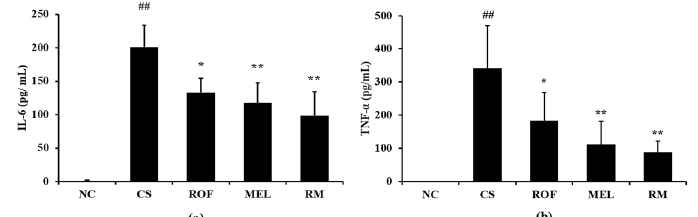
Figure 3. Melatonin decreased inflammatory cytokines in BALF of CS-exposed mice. The level of inflammatory cytokines was determined by ELISA assay. ( a ) Level of IL-6 and ( b ) level of TNF-α. NC: non-treated and non-exposure group; CS: PBS-treated and CS+LPS exposure group; ROF: roflumilast-treated and CS+LPS exposure group, MEL: melatonin-treated and CS+LPS exposure group, RM: roflumilast and melatonin co-treated and CS+LPS exposure group. The data are expressed as mean ± SD (n = 5). ## Significantly different from the NC group, P < 0.01; *, ** significantly different from the CS group, P < 0.05 and P < 0.01, respectively.